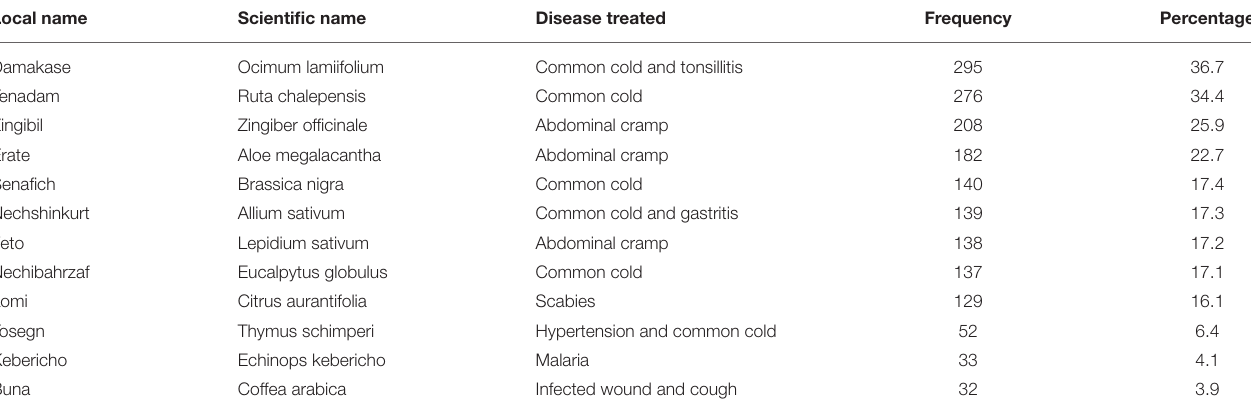
TABLE 3 | Traditional medicine used by study participants in Harari region, Eastern Ethiopia, 2022.